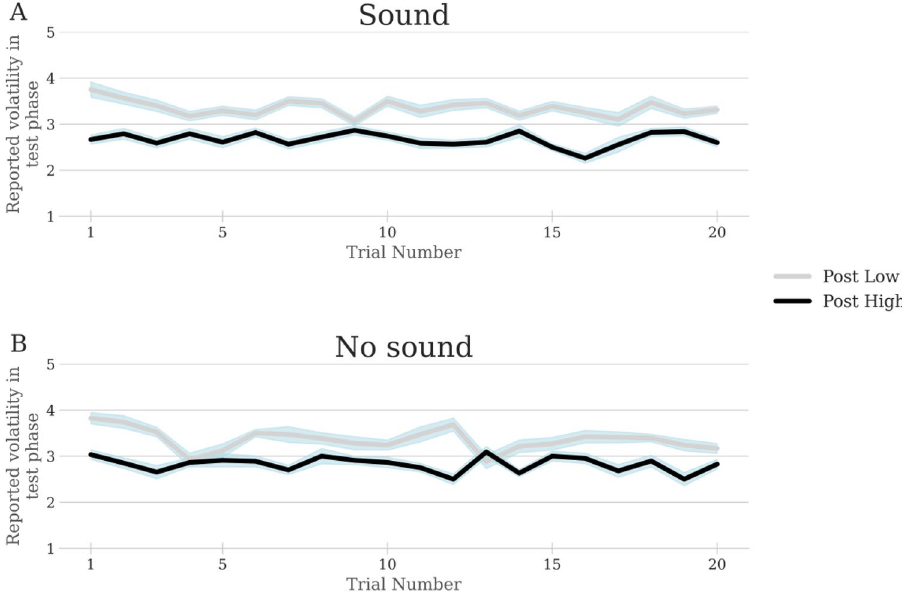
Figure 4. Time invariance of after-effect size in the treatment without sound ( A ) and the treatment with sound ( B ). The graph plots the average reported volatility on the scale (1: very low; 2: low; 3: medium; 4: high; 5: very high) for the medium-volatility test stimulus after exposure to high volatility (“post high”) vs. after exposure to low volatility (“post low”) at each trial. X-axis: trial number (1–28). Y-axis, “Post High”: Average reported volatility of the medium-volatility test stimulus across task participants who underwent high volatility in the adaptation phase of the corresponding trial; “Post Low”: Average reported volatility of the medium-volatility test stimulus across participants who underwent low volatility in the adaptation phase of the corresponding trial. For each trial, the difference between the post low and post high curves measures the size of the risk after-effect across participants. Shaded blue area shows standard error of the mean (sem).